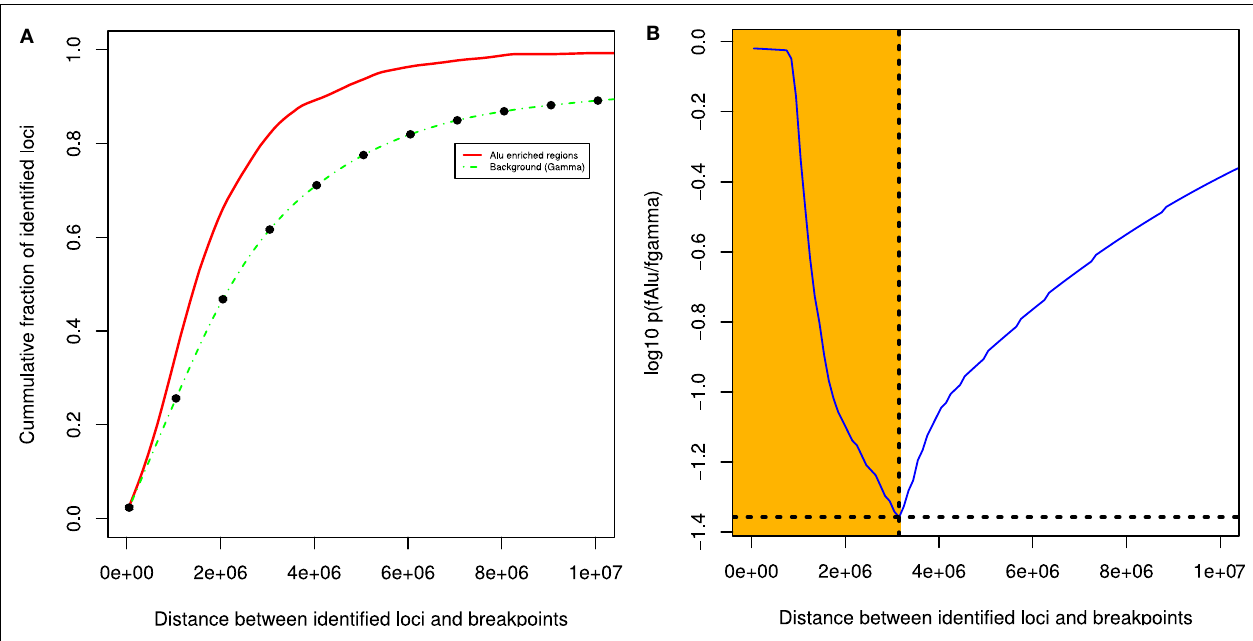
FIGURE 5 | Breakpoint enriched DMR tend to co-localize withAlu enriched regions. The statistical evaluation shows that Alu enriched regions and BEDMRs co-localize within a distance of 3MB (A,B)